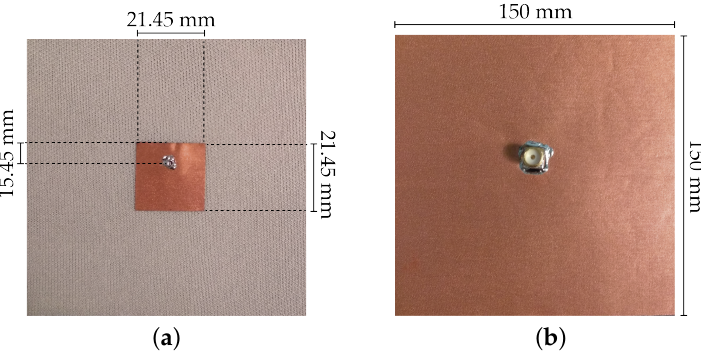
Figure 7. Textile microstrip patch antenna used as control sample: ( a ) front and ( b ) back. The textile microstrip patch antennas were manufactured with a laminating technique.